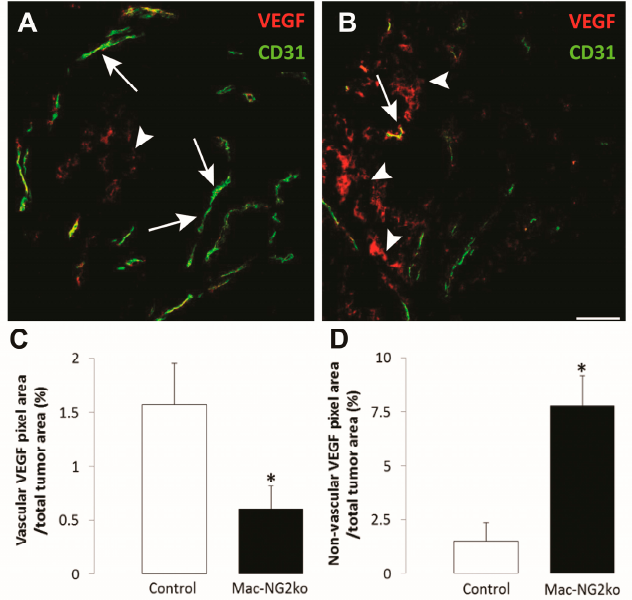
Figure 5. Altered VEGF-A localization following myeloid-specific ablation of NG2. Double immunostaining for VEGF-A (red) and CD31 (green) was used to quantify and localize VEGF-A sequestration in tumors from control ( A ) and Mac-NG2ko ( B ) mice. VEGF-A in control tumors is highly localized to blood vessels, while vascular VEGF-A in Mac-NG2ko tumors is reduced 3-fold ( C ). Instead, non-vascular VEGF-A in Mac-NG2ko tumors is increased by a factor of 5 ( D ). Scale bar = 60 µ m. * p < 0.01 compared to controls. Data taken from Yotsumoto, et al.